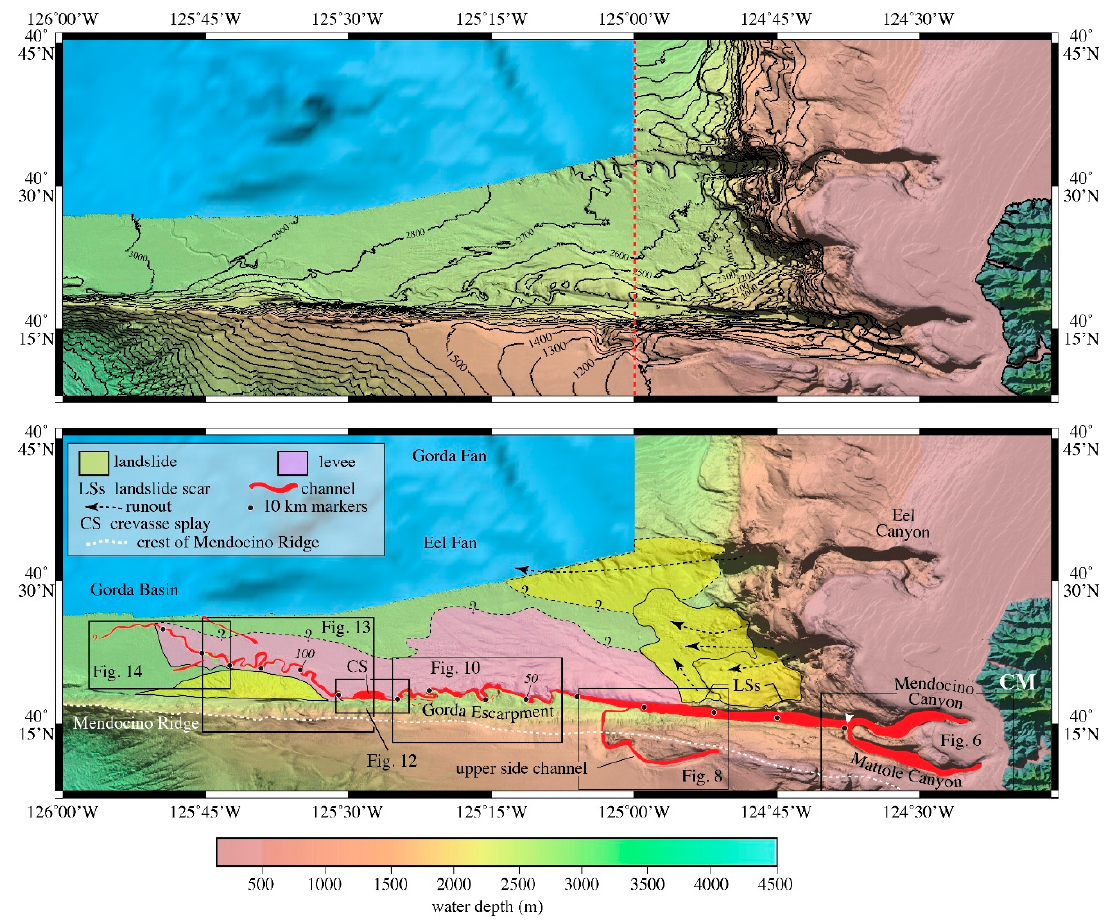
Figure 2. ( Upper ) Overview map view of multibeam bathymetry of the summit and northern flank of Gorda Escarpment, southern-most Gorda Fan and Gorda Basin to the north. Bathymetry east of red dashed line from NOAA Coastal Relief Model (https://ngdc.noaa.gov/mgg/coastal/crm.html) (See text). Contour interval 100 m. ( Lower ) Locations of Mendocino and Mattole Canyon channels and upper side channel (red), landslides (yellow) and levees (purple). Black circles every 10 km mark distances in italics from the junction of Mendocino and Mattole Canyons. White “CM” is Cape Mendocino, Calif., white arrow head is location where Mendocino Channel captured Mattole Channel. LSs is landslide scar. Locations of subsequent figures shown as black rectangles.